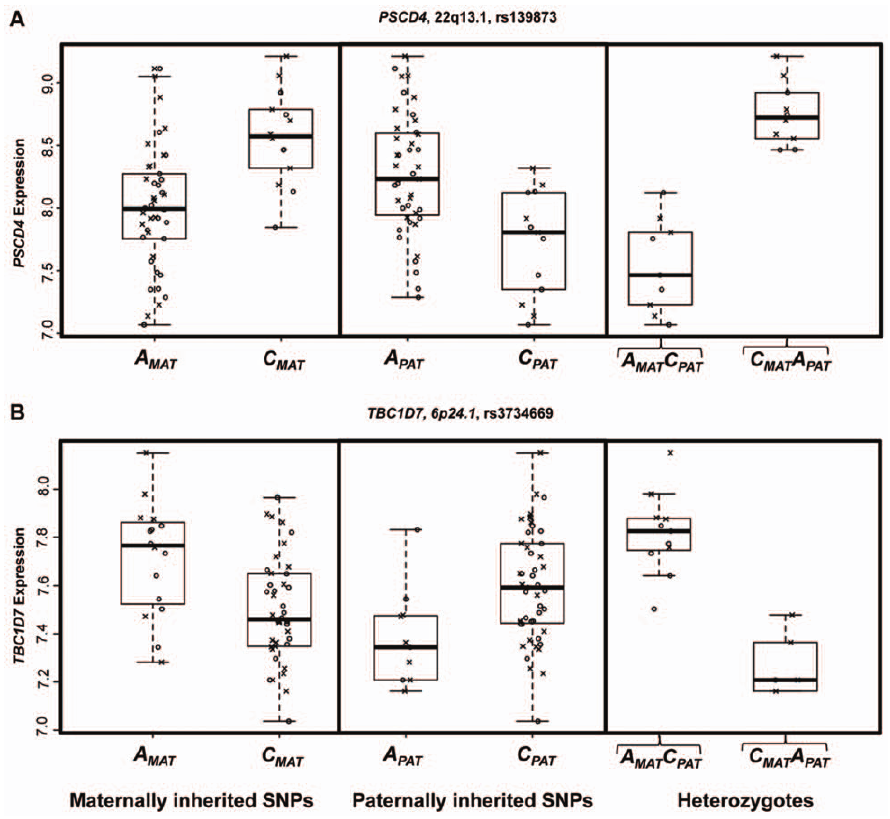
Figure 4. The two most significant SNP-gene pairs identified using the Likelihood Ratio Test. Results for (A) PSCD4 and (B) TBC1D7 . In each plot the three panels show variation of gene expression with respect to maternally inherited SNPs, paternally inherited SNPs and two classes of heterozygotes, respectively. Box plots show the distributions of gene expression for CEU ( circles ) and YRI offspring ( crosses ) with respect to maternally ( MAT ) and paternally ( PAT ) inherited SNPs. Note that unlike loci identified using separate association with maternal and paternal alleles where a difference in gene expression level is seen for only one of the two parental alleles, for both genes the A and C alleles have opposite effects on gene expression when inherited maternally versus paternally.